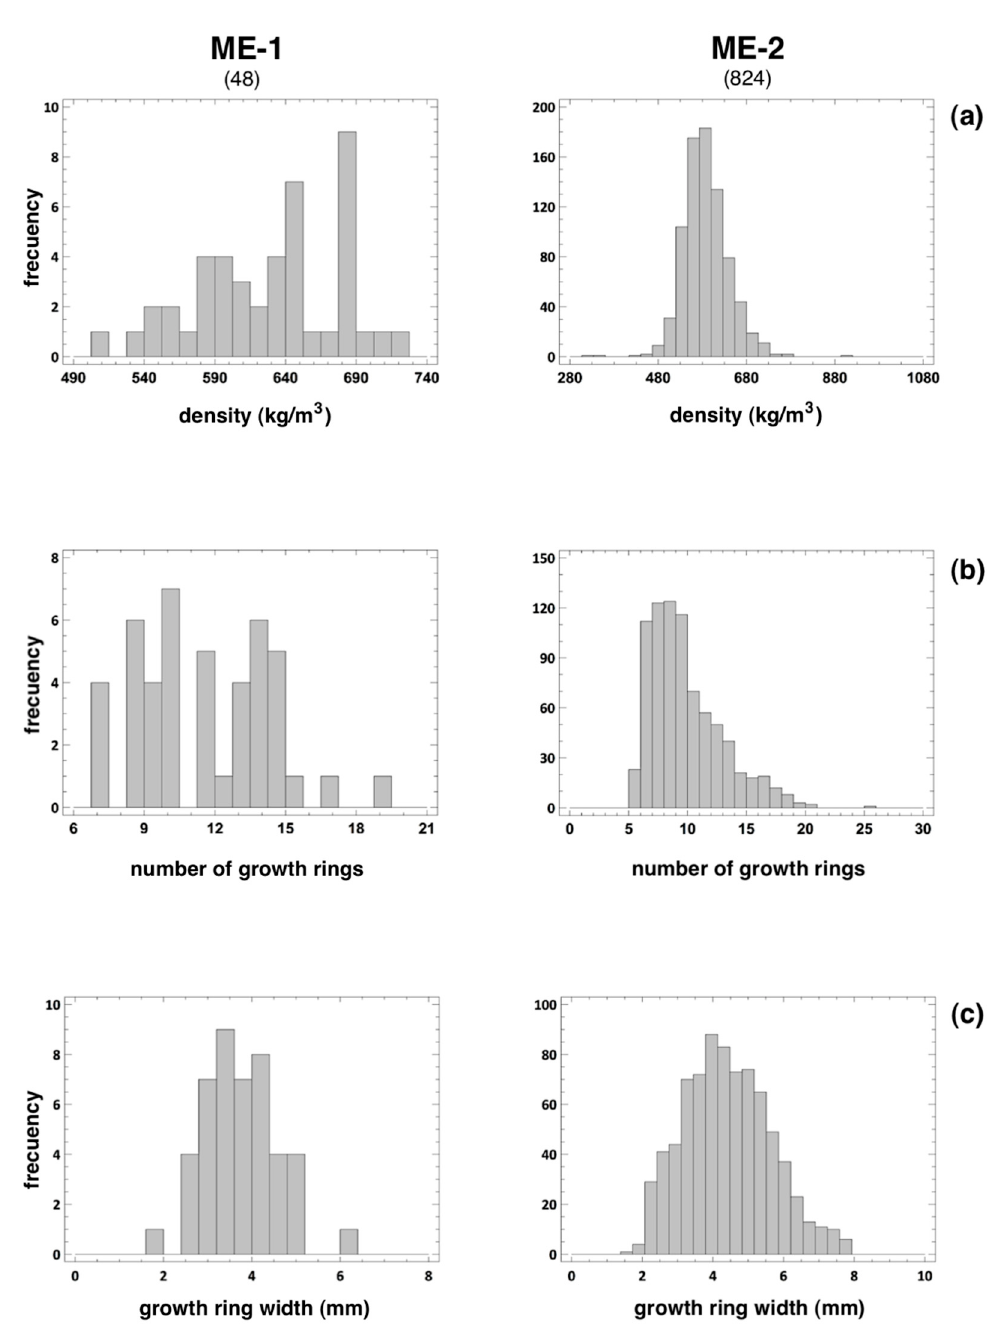
Figure 5. Distribution histograms of ( a ) density, ( b ) number of growth rings and ( c ) growth ring width.